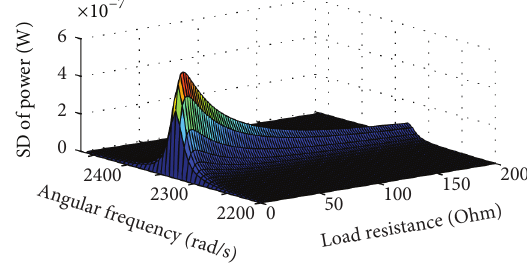
Figure 6: SD of the power as a function of angular frequency and load resistance for 𝑄 𝑚 = 5.7 and 𝐺 = 0.1